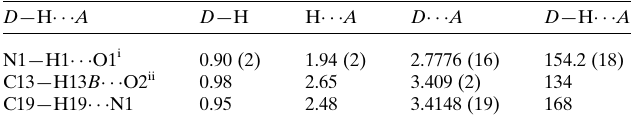
Table 3 Hydrogen-bond geometry (A˚ , (cid:3) ) for